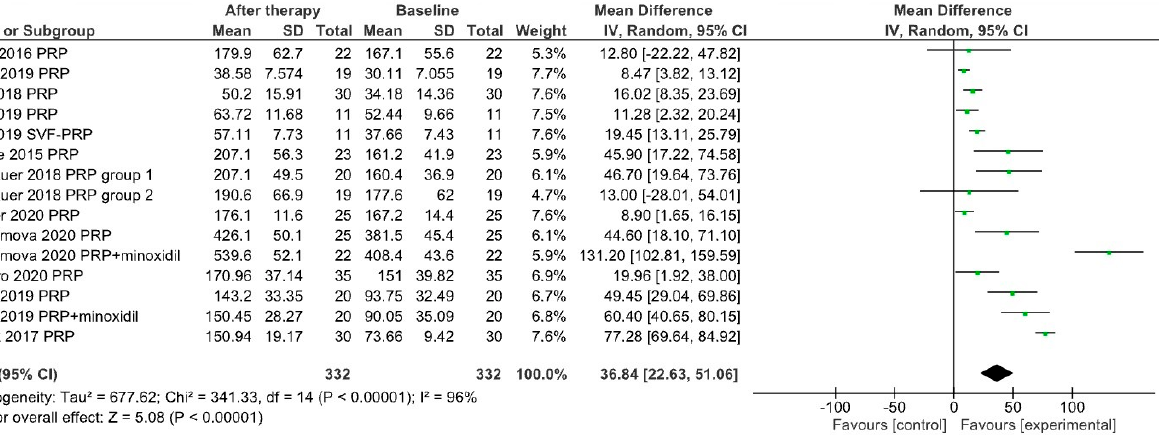
Figure 2. Effects of PRP treatments on absolute and percentage change in hair density within the clinical trials selected for meta-analysis. ( a ) absolute changes in hair density (hairs/cm 2 ) at the end of evaluation period. ( b ) percentage changes in hair density relative to initial values. The legend is the same for both graphs. Data for experimental groups where only PRP treatment was applied are marked with squares, those where minoxidil treatment was added are marked with hollow star symbols.